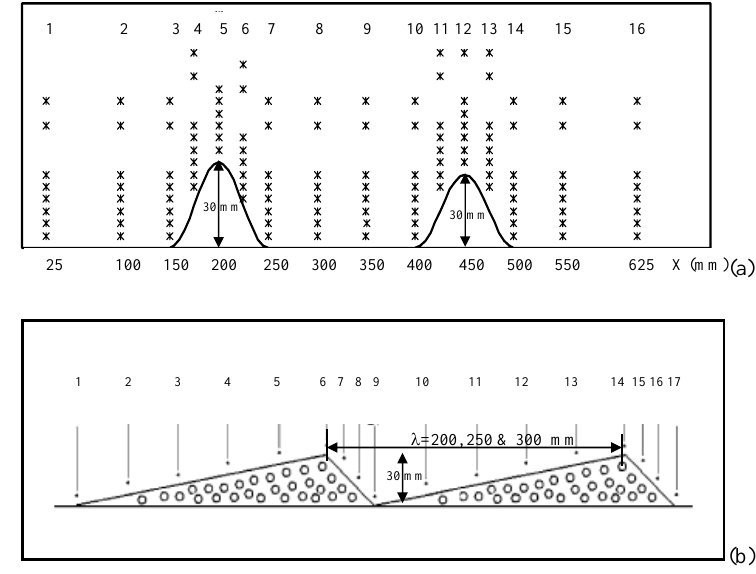
Figure 3- Sections and points of velocity measurement a) the sinusoidal ripple; b) the triangular ripple Fig. 3. Sections and points of velocity measurement (a) the sinusoidal ripple; (b) the triangular